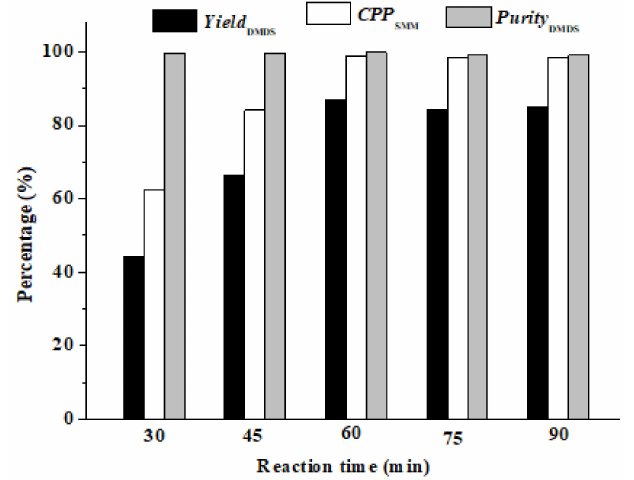
Figure 7. The effect of reaction time on CPP SMM , Yield DMDS , and Purity DMDS using the AC-CoPcS catalyst. Experimental conditions: SMM (18.0 wt%) 450 g, RR = 600 r/min, C ca = 888.9 ppm, T re = 65 ◦ C, P (O 2 ) = 0.9